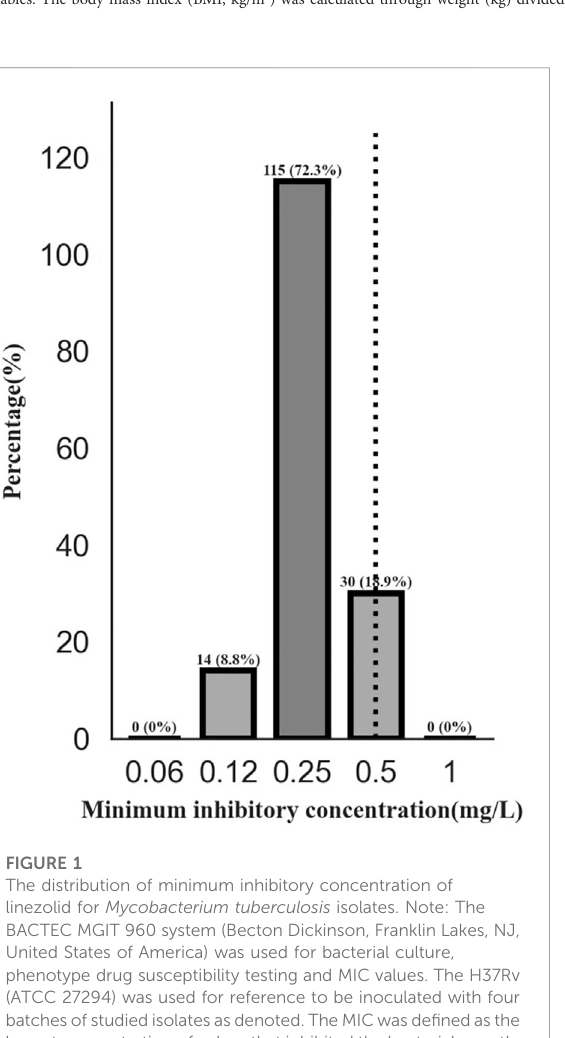
visual predictive check plots (Figure 2). The VPC for the entire data set demonstrated a good prediction of the model (Figure 3).